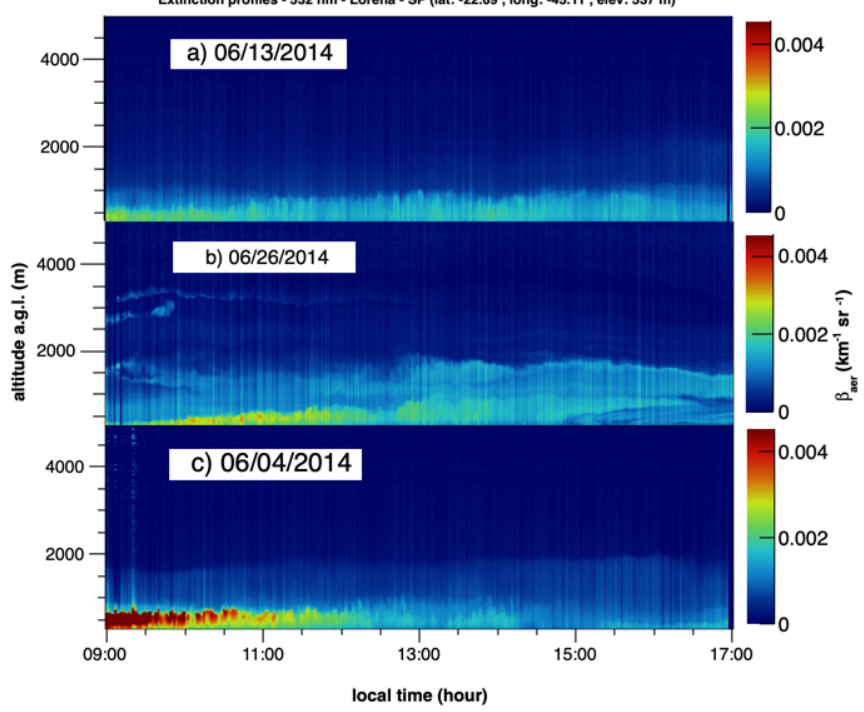
Figure 6. Aerosol backscatter profiles for three representative measurement days in Lorena city: ( a ) Clean day; ( b ) day with possible transport of aerosols; and ( c ) polluted day. The daily average backscatter profiles are presented in Figure 8 for the same